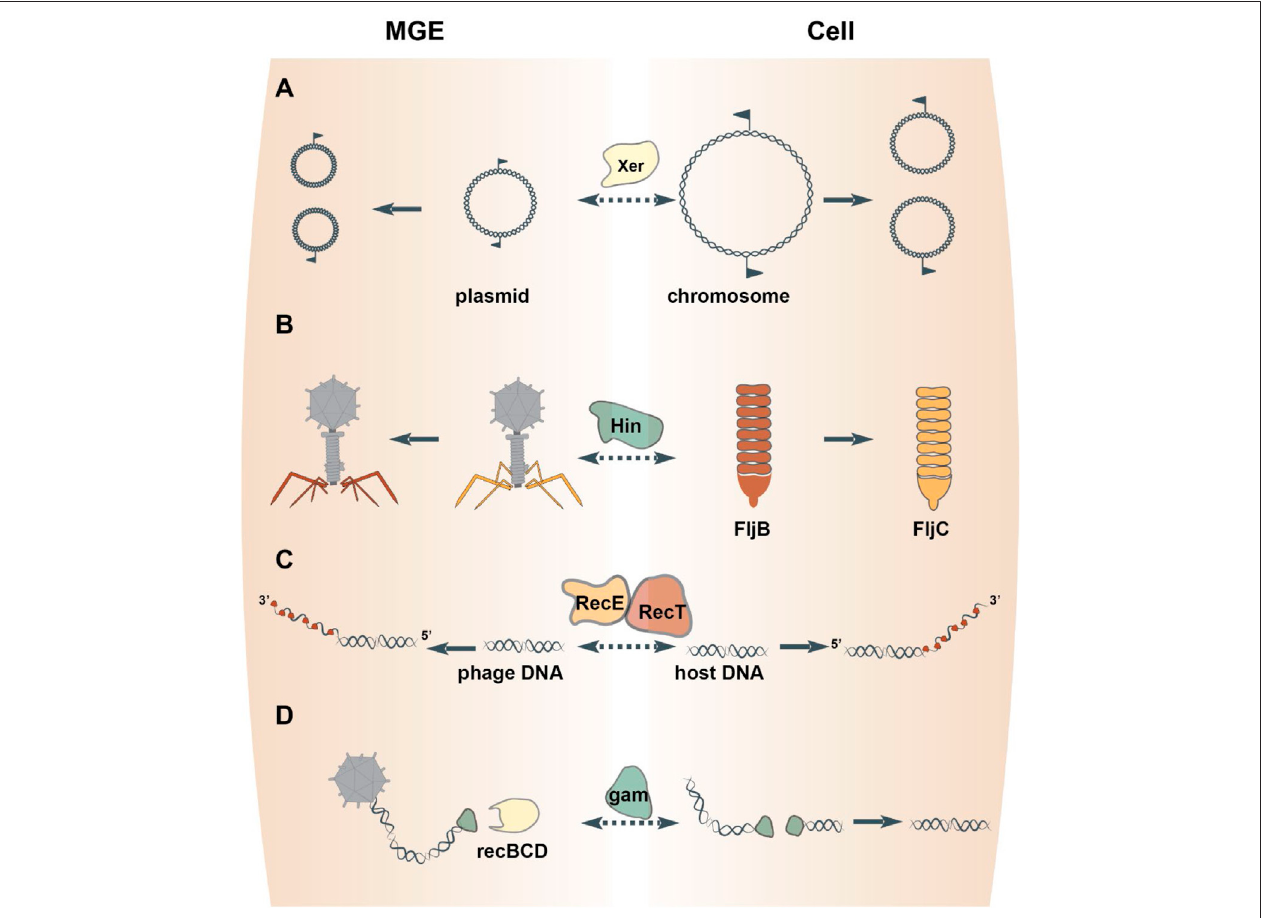
FIGURE 2 | Proteins involved in DNA replication, recombination and repair freelance between MGEs and cells. Homologous resolvases mediate the resolution of both MGE and chromosomereplicationintermediates (A) . DNAinvertingserinerecombinases directthe expression ofalternative phage tail fi ber genesor host fl agellum genes (B) . Exapted bacteriophage genes endow the host DNA repair pathways via homologous recombination (C) or nonhomologous end-joining (D)